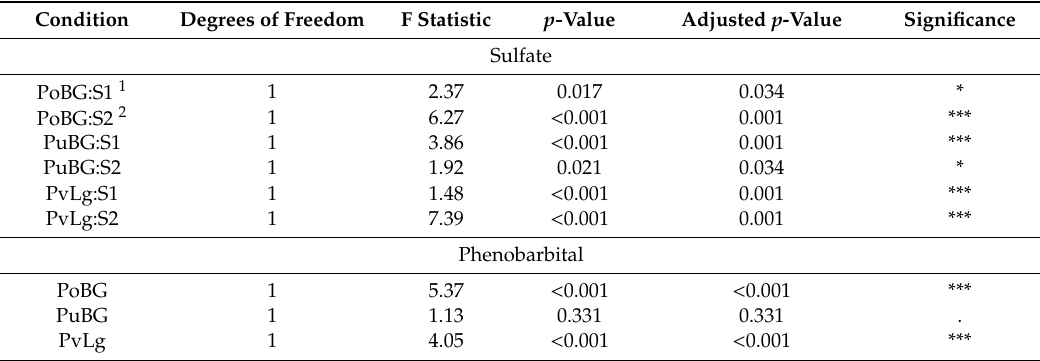
Table 3. E ff ect size and significance of sulfate on beta diversity within the location and season, and phenobarbital within the location. p -values were adjusted for multiple testing with the